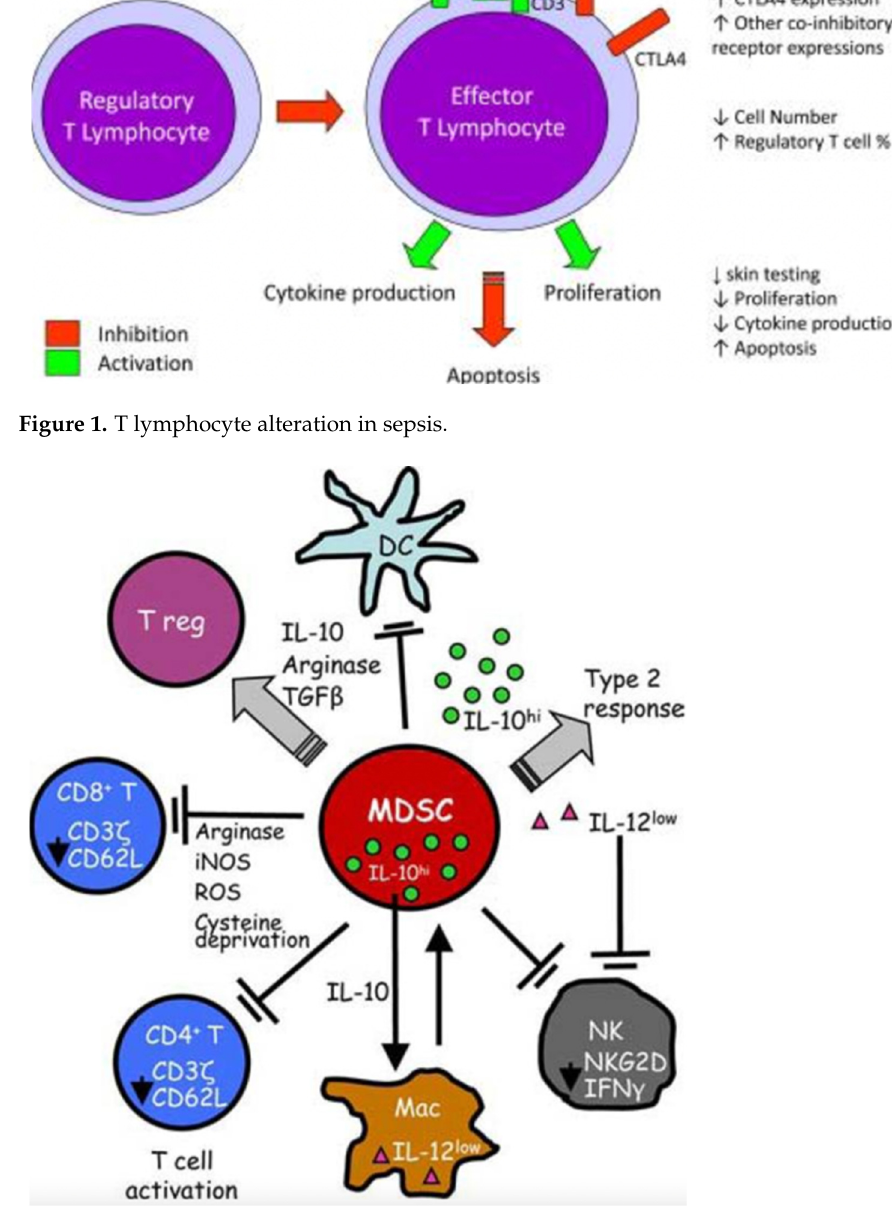
Figure 2. MDSCs suppress antitumor immunity through a variety of mechanisms. T cell activation is suppressed by the production of arginase and ROS, cysteine deprivation and the induction of Tregs. Innate immunity is impaired by the down-regulation of macrophage-produced IL12, the production of IL10 and the suppression of NK